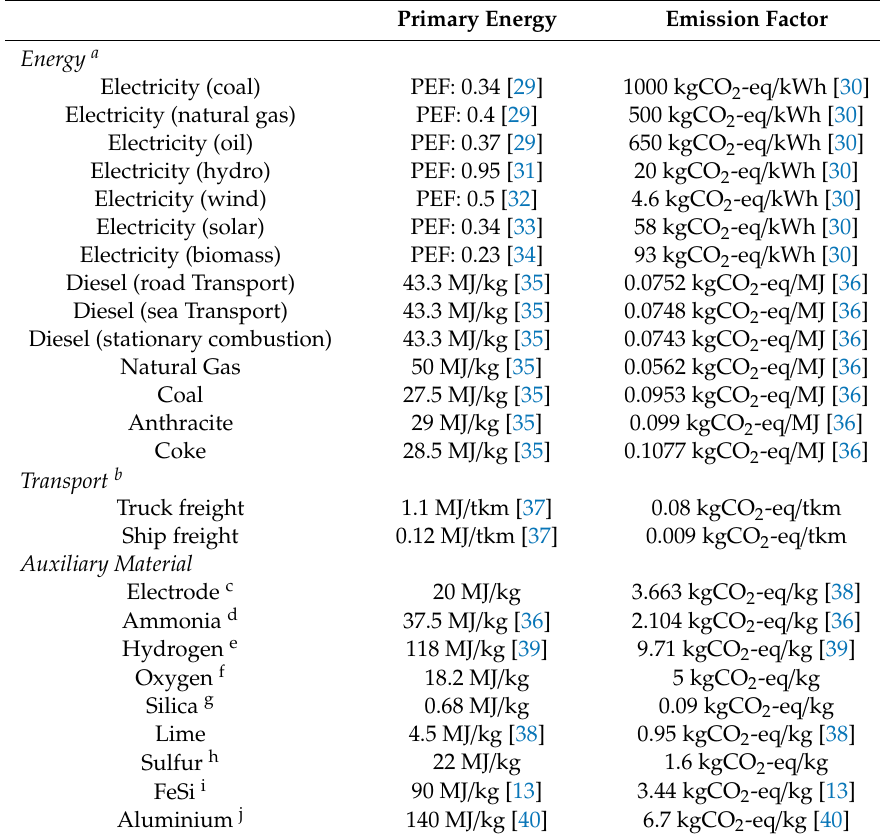
Table 3. Conversion factor of